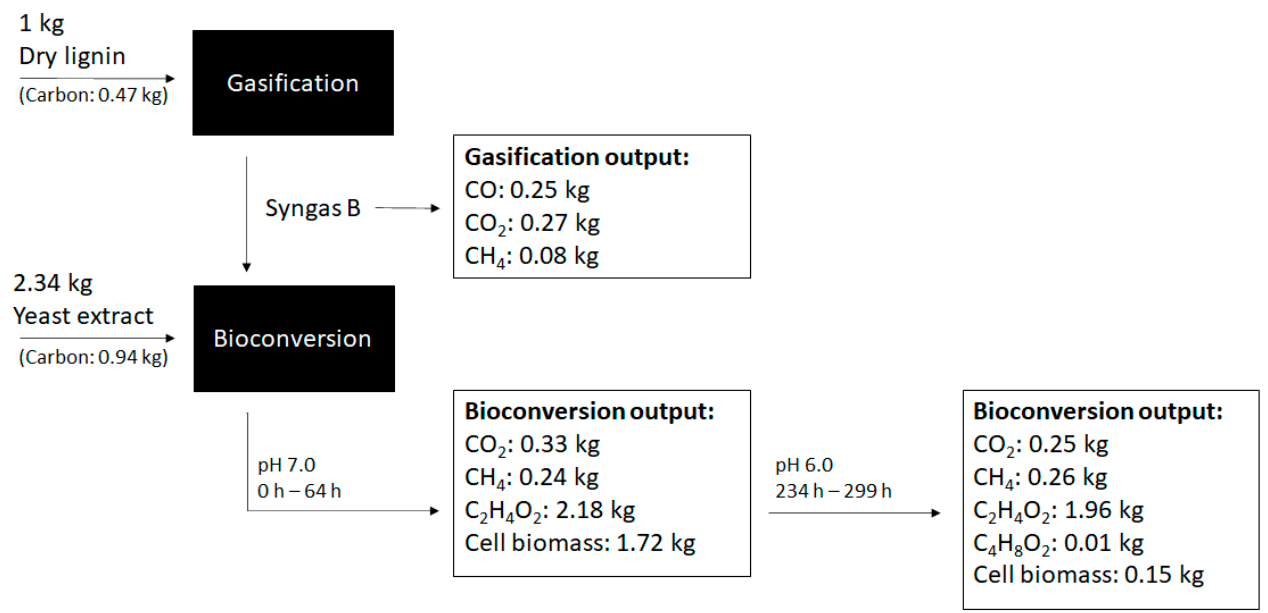
Figure 5. Process schematic of Syngas B production and bioconversion, representing the carbon inputs and outputs per kg of dry lignin.